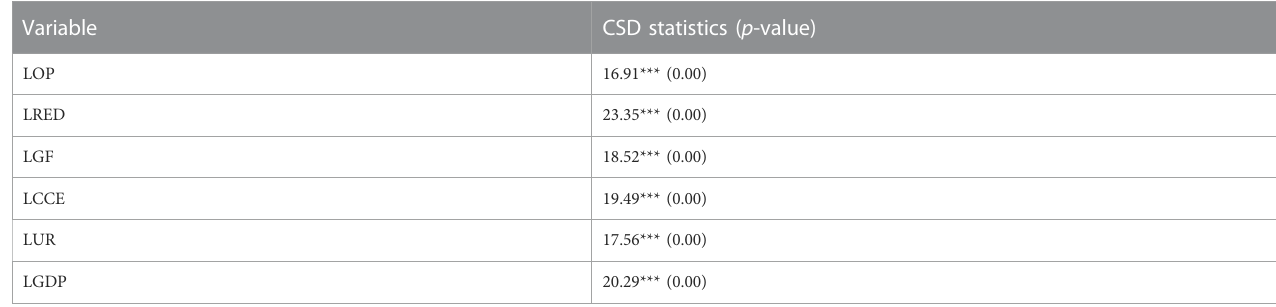
TABLE 3 CSD test results analysis.